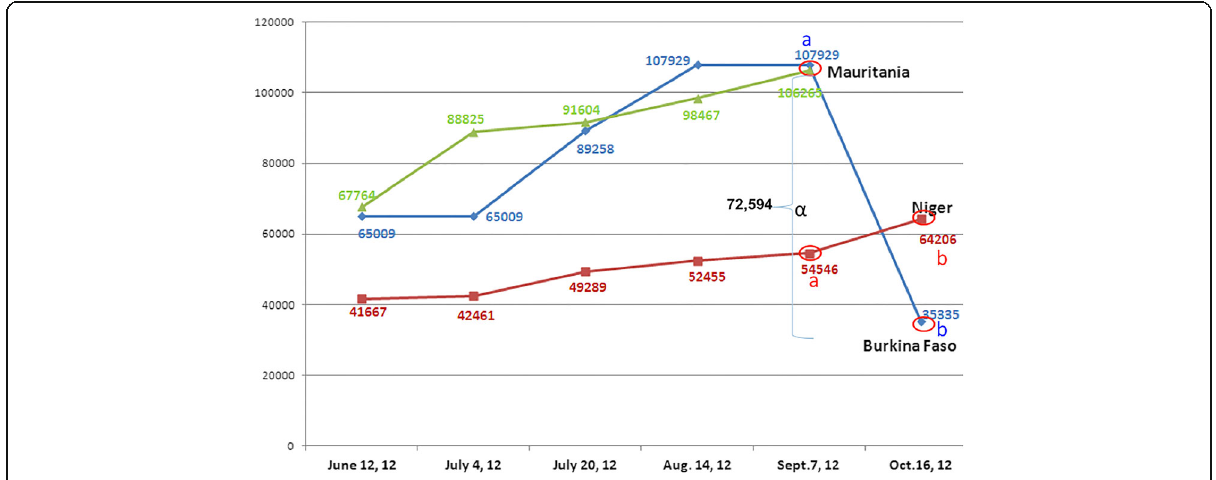
Fig. 1 Evolution of Malian refugees count in the major host countries. a Official figure before level 2 census release. b Refugees population from Level 2 census. α : Difference between the refugees official count and the real population (level 2 census). Source: Compile from UNHCR